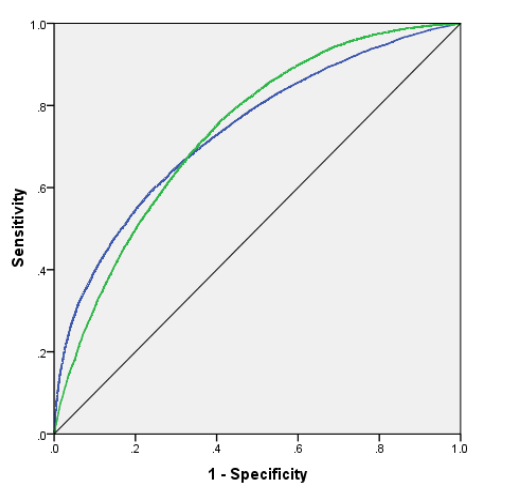
Figure 2. ROC graphs of ANN